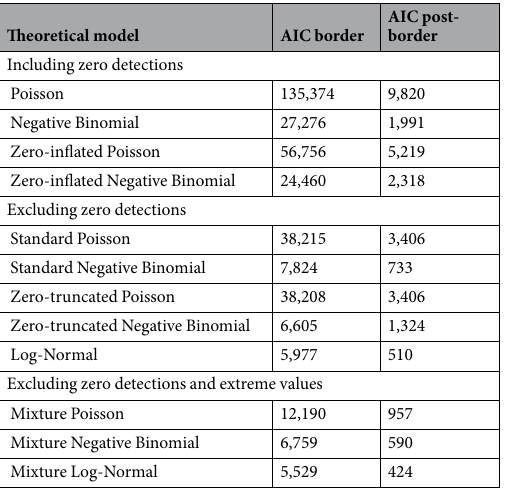
Table 1. Models of the data in Fig. 2 and values of